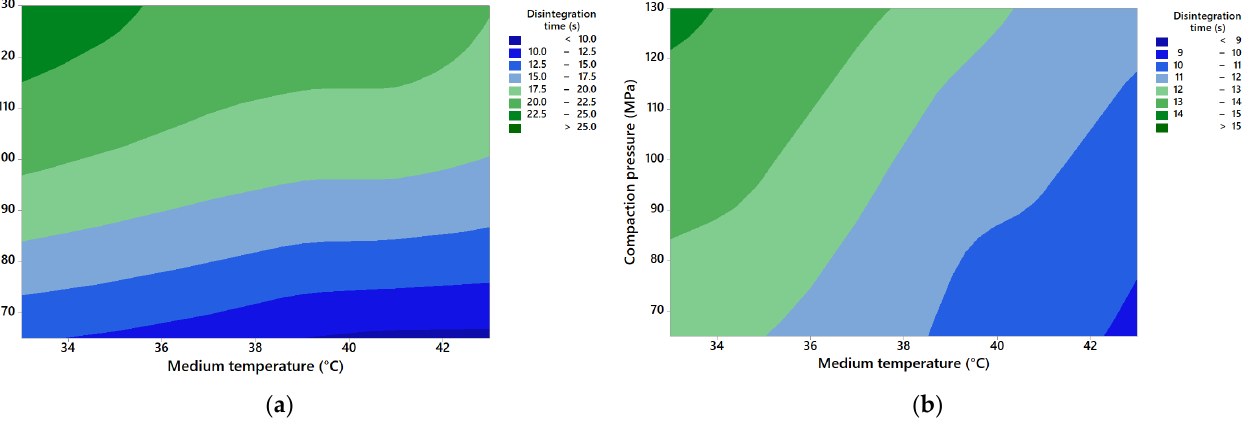
Figure 4. Contour plots of disintegration time against disintegration medium temperature and compaction pressure for tablets containing ( a ) SSG or ( b ) XPVP.